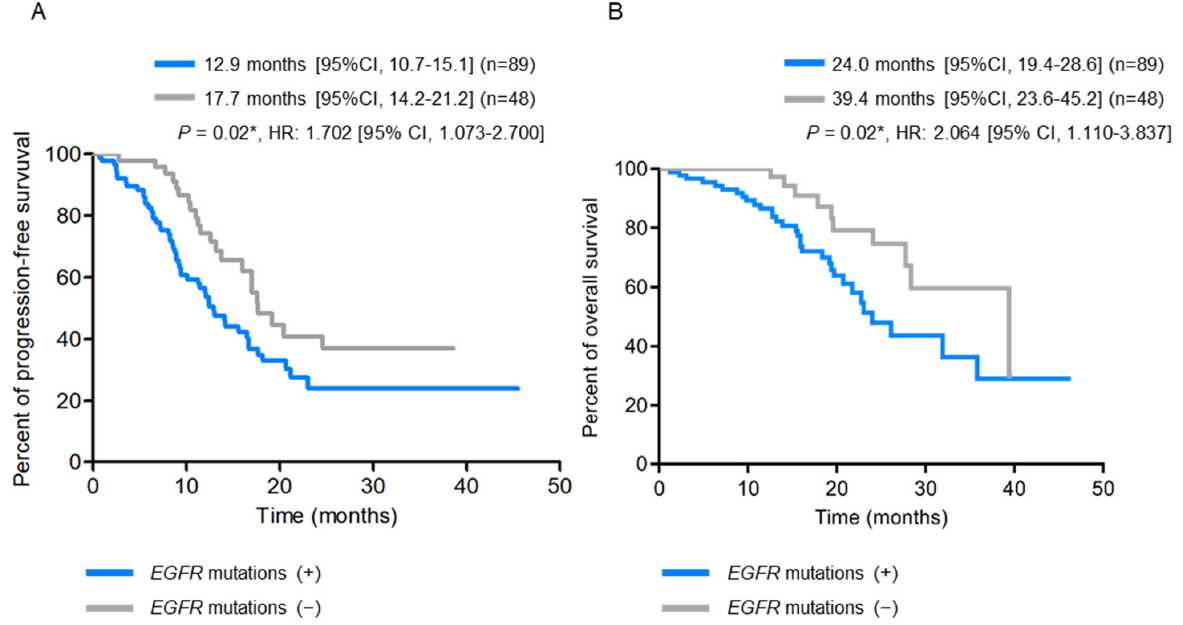
Figure 3. Kaplan-Meier survival analysis according to baseline plasma EGFR -activating mutation status (N = 137). ( A ) Progression-free survival (PFS) curves. ( B ) Overall survival (OS) curves. * p < 0.05, indicating